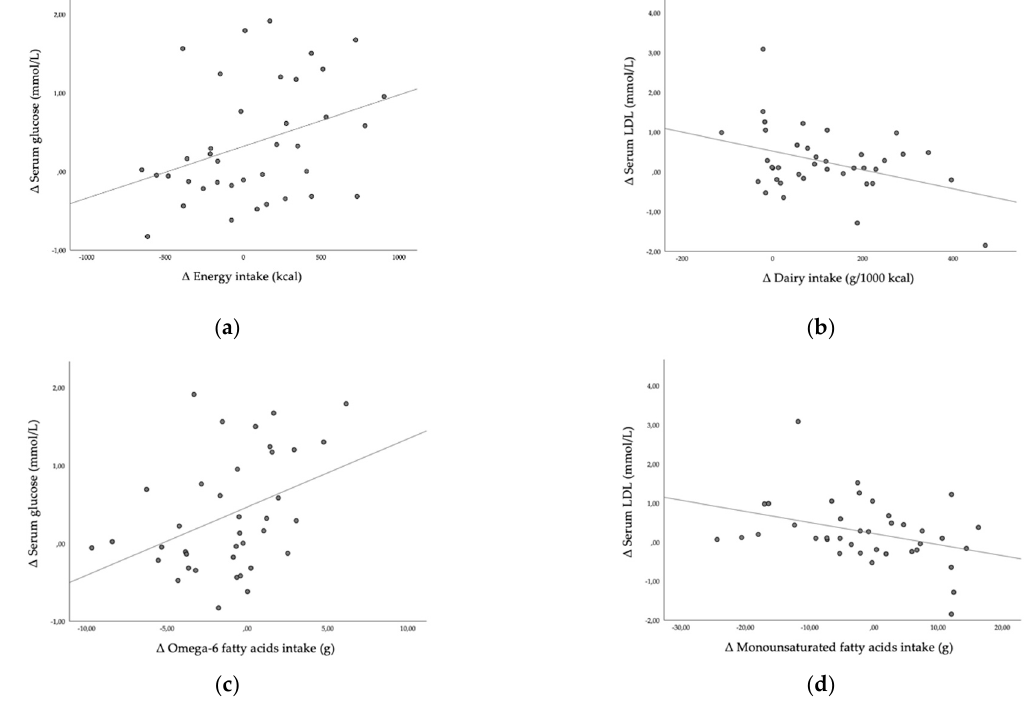
Figure 3. ( a ) Correlation between Δ energy intake and Δ serum glucose; ( b ) correlation between Δ dairy intake and Δ serum LDL; ( c ) correlation between Δ omega-6 fatty acids intake and Δ serum glucose; ( d ) correlation between Δ monounsaturated fatty acids intake and Δ serum LDL; Δ —change of post-lockdown value from baseline.